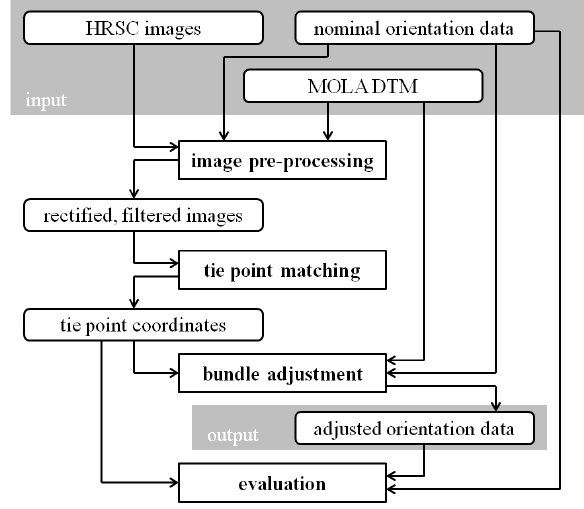
Figure 2: Workflow for systematic bundle adjustment of HRSC image